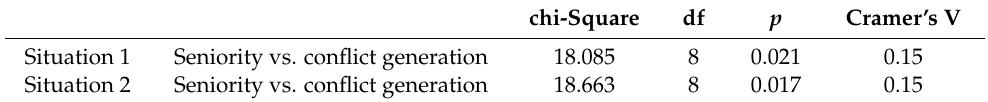
Table 2. Results of the correlation analysis of the variables seniority vs. quality of the decision